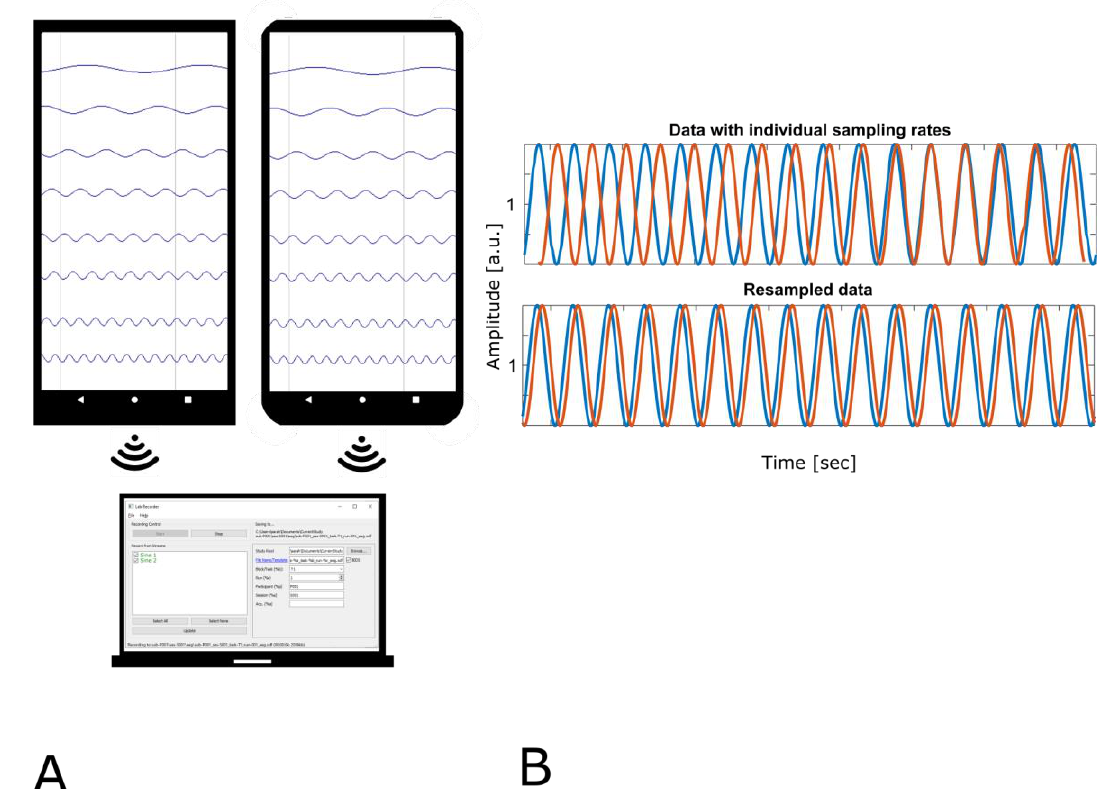
Figure 1. ( A ) Illustration of the setup of scenario 1A. Two phones were running the Sine-Wave app, while LabRecorder on PC recorded all data streams. Data were streamed with different sampling rates. ( B ) Illustration of a misalignment over time. Shown are 4 s of data. The upper plot shows data on their respective time scales diverging over time. The lower plot shows temporally aligned (resampled) data.